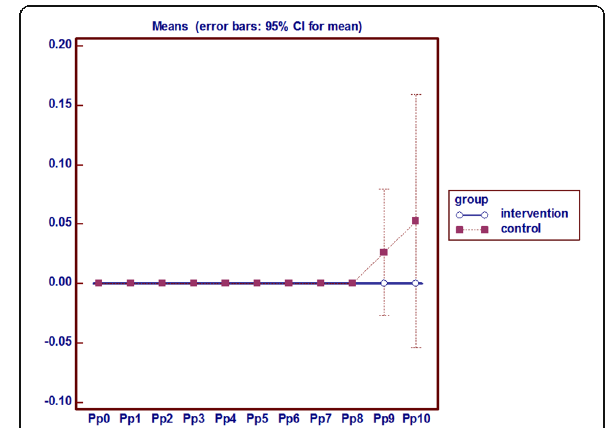
Fig. 7 Analysis of variance with repeated measures on the heel